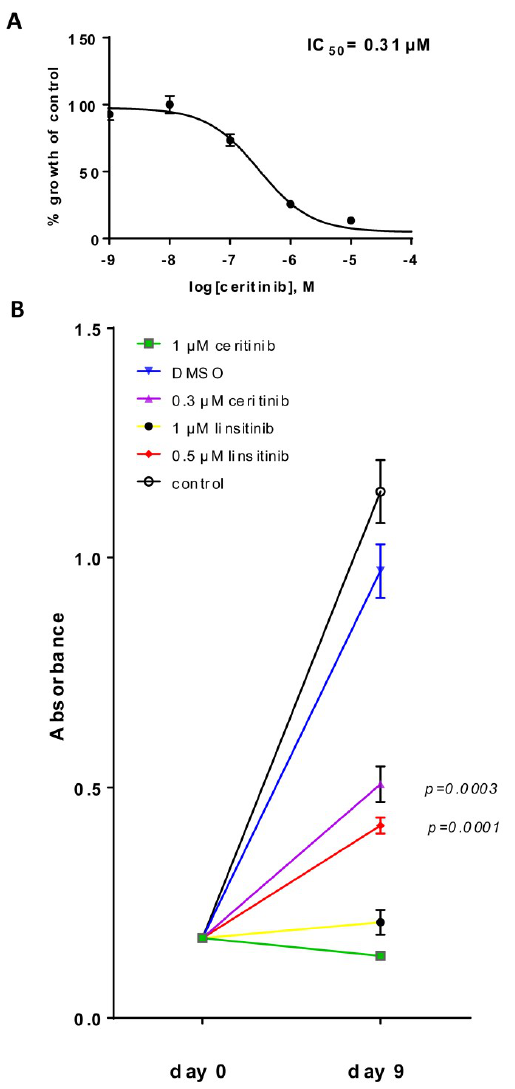
Figure 4. HGNET-BCOR is sensitive to the inhibition with ceritinib: ( A ) PhKh1 cells were treated with ceritinib at concentrations from 1 nM to 100 μM. The X-axis shows the logarithm of M, and the Y-axis the percent of viable cells compared to the control cells treated with DMSO. The GraphPad software was used to create the dose–response curve. A representative experiment of three independent experiments is shown. ( B ) PhKh1 cells were grown for 9 days in the presence of ceritinib, linsitinib, vehicle alone (DMSO), or without any treatment (control) at the indicated concentrations. Absorbance after incubation with the WST-1 reagent is indicated. Statistics were performed using Student’s t -test at day 9 compared to the DMSO control. A representative experiment of three independent experiments is